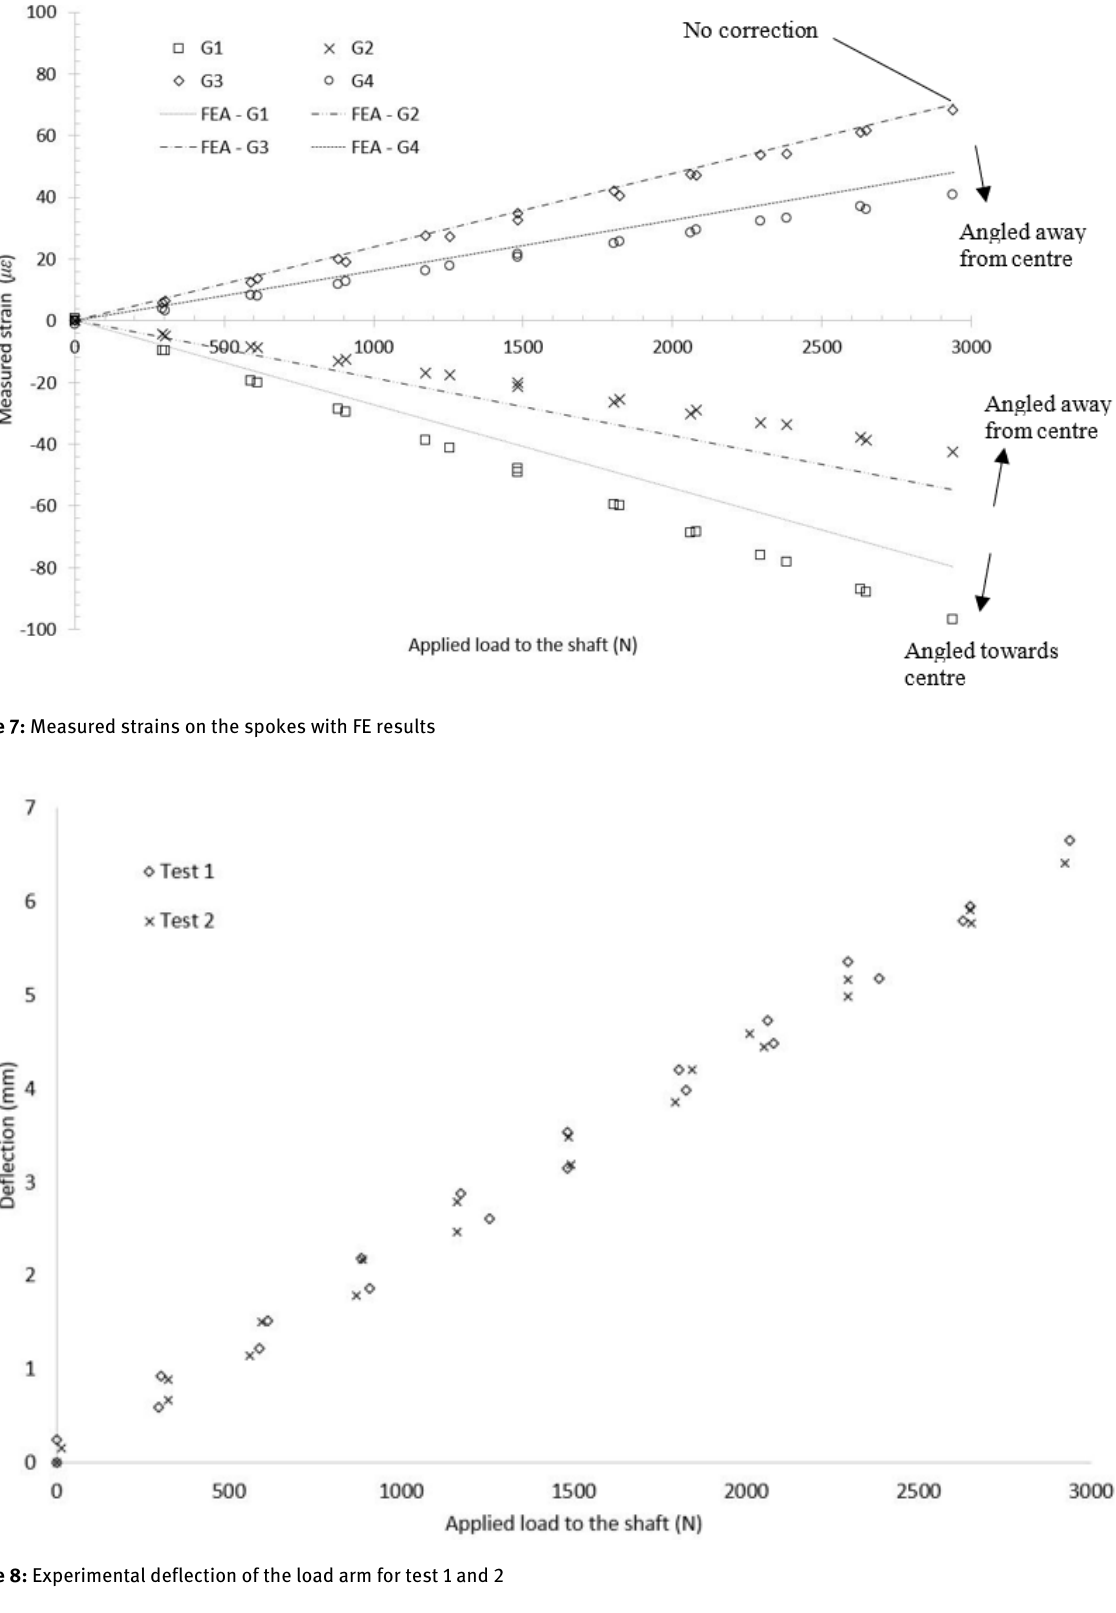
Figure 8: Experimental deflection of the load arm for test 1 and